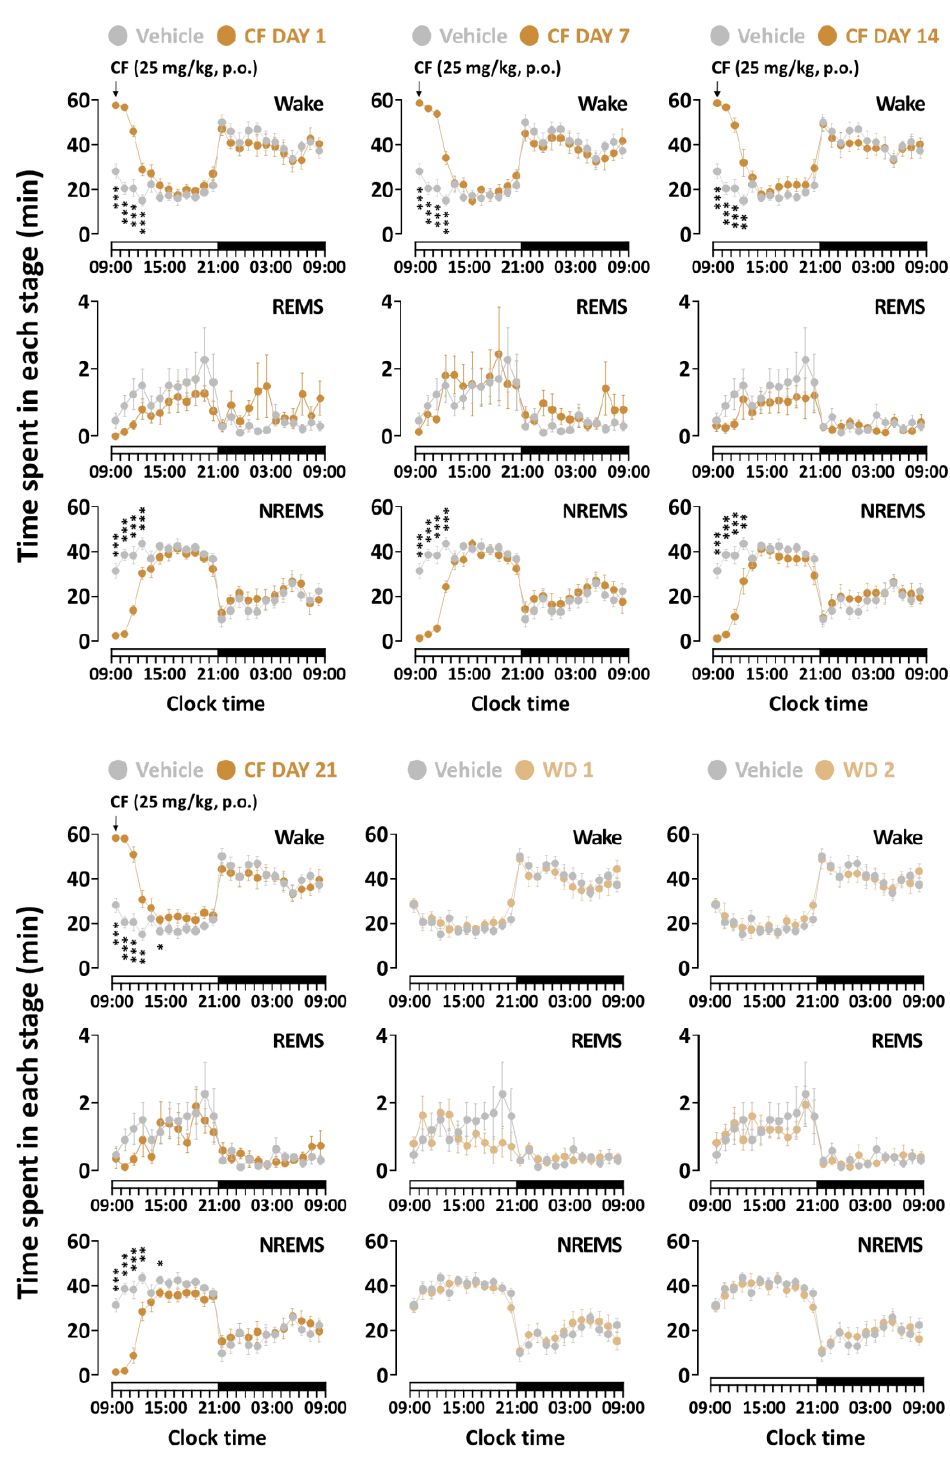
Figure 3. Time-course changes of caffeine (25 mg/kg) treatment during each stage over the whole administration period. Grey circles illustrate the baseline day (vehicle). Brown circles illustrate caffeine treatment. Light brown circles illustrate the withdrawal (WD) day during the end of caffeine treatment. Every circle denotes the hourly mean ± SEM ( n = 7–8) in each stage. * p < 0.05, ** p < 0.01, and *** p < 0.001 indicate significant differences compared to the vehicle (Dunnett’s test). BL, baseline; CF, caffeine; NREMS, non-rapid-eye-movement sleep; REMS, rapid-eye-movement sleep; Wake, wakefulness; SEM, standard error of the mean.